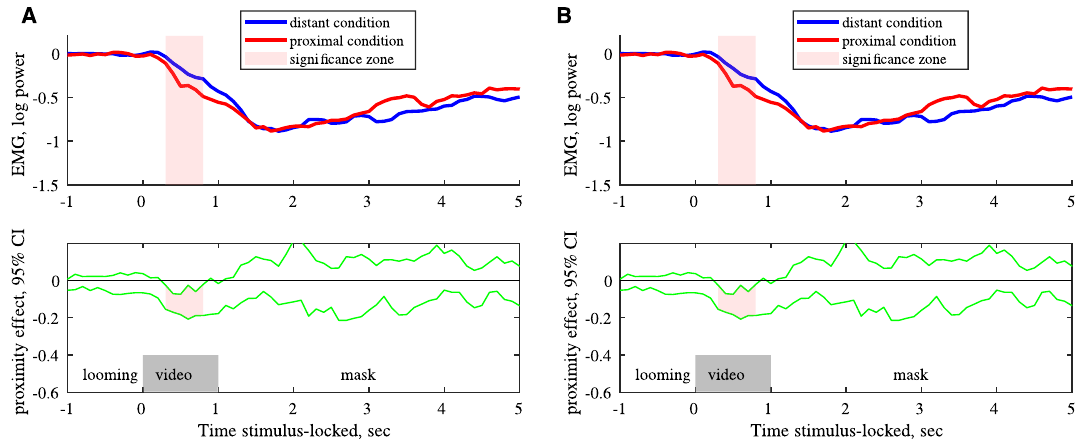
Figure 1. Corrugator supercillii activity during observation ( A , n = 41) and imitation ( B , n = 36) of happy faces. Upper row: the median of EMG activity for distant and proximal conditions. Lower row : 95% confidence intervals for effect of condition (proximal vs distant conditions). Pale pink shadow indicates clusters of data points with significant differences between proximal and distant conditions (A - p < 0.001 and B - p < 0.05 cluster level based on median bootstrap permutation test, n =